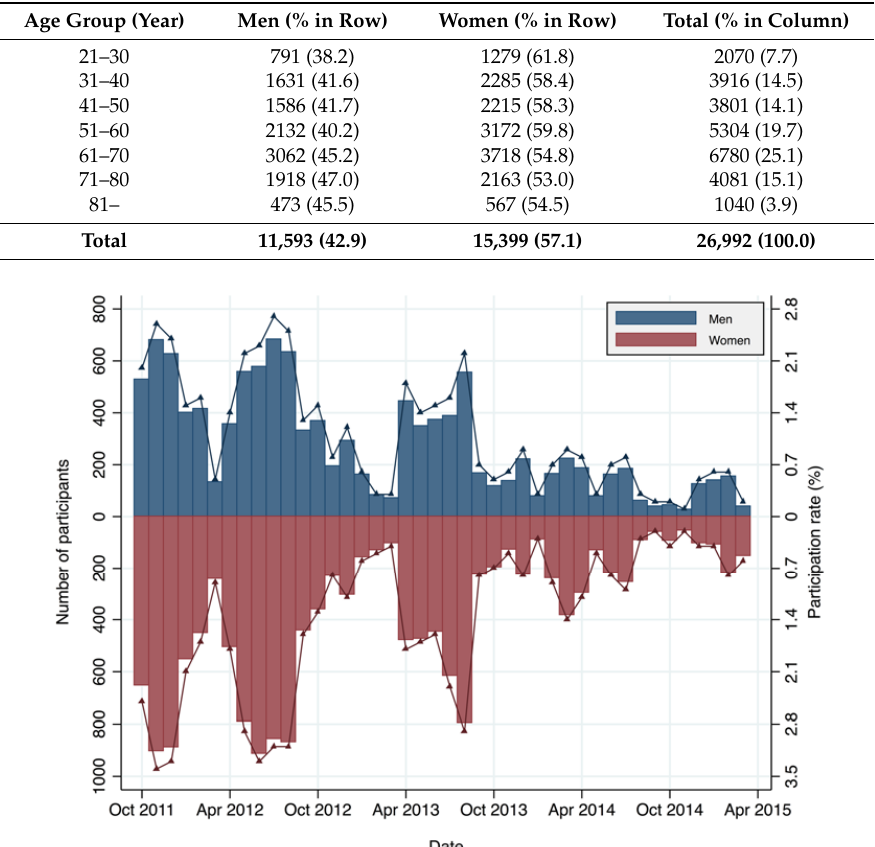
Figure 2. Monthly number of while body counter monitoring participants aged 21 years and older and participation rates (%) in the whole population by sex. Bar: Number of participants (left Y-axis), solid line: Participation rate (right Y-axis).